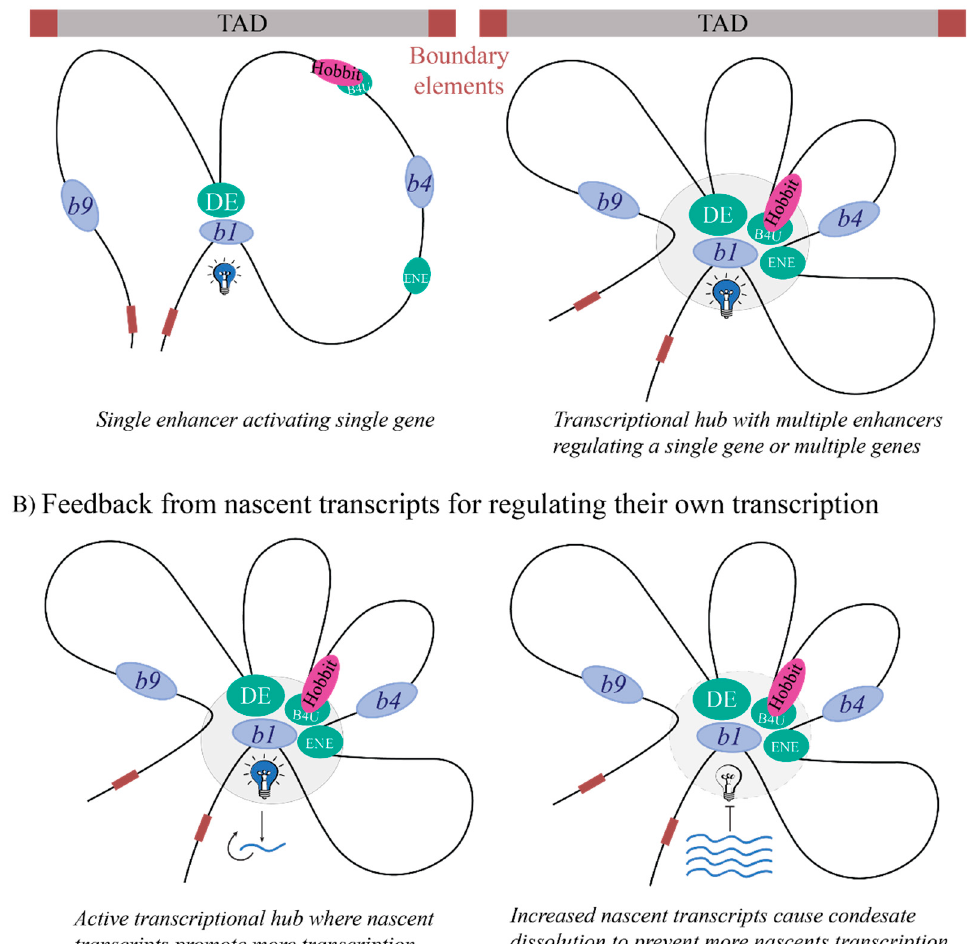
Figure 3. Schematic of how the chromatin may loop to activate genes within the transcriptionally complex Hoxb gene cluster ( A ) Different loop confirmations envisioned for activation of specific genes within the Hoxb cluster, which contains several enhancer elements (such as DE, B4U and ENE) as well as coding and non-coding genes. ( B ) Inference [41,44] for how nascent Hoxb transcripts may promote condensate formation to increase nascent transcription, and subsequently, how an increased number of nascent transcripts may inhibit transcription by promoting condensate dissolution. Brown boxes at cluster edges depict boundary elements, blue and pink colored ovals depict coding genes and non ‐ coding RNAs, respectively, and green ovals are RARE enhancers.